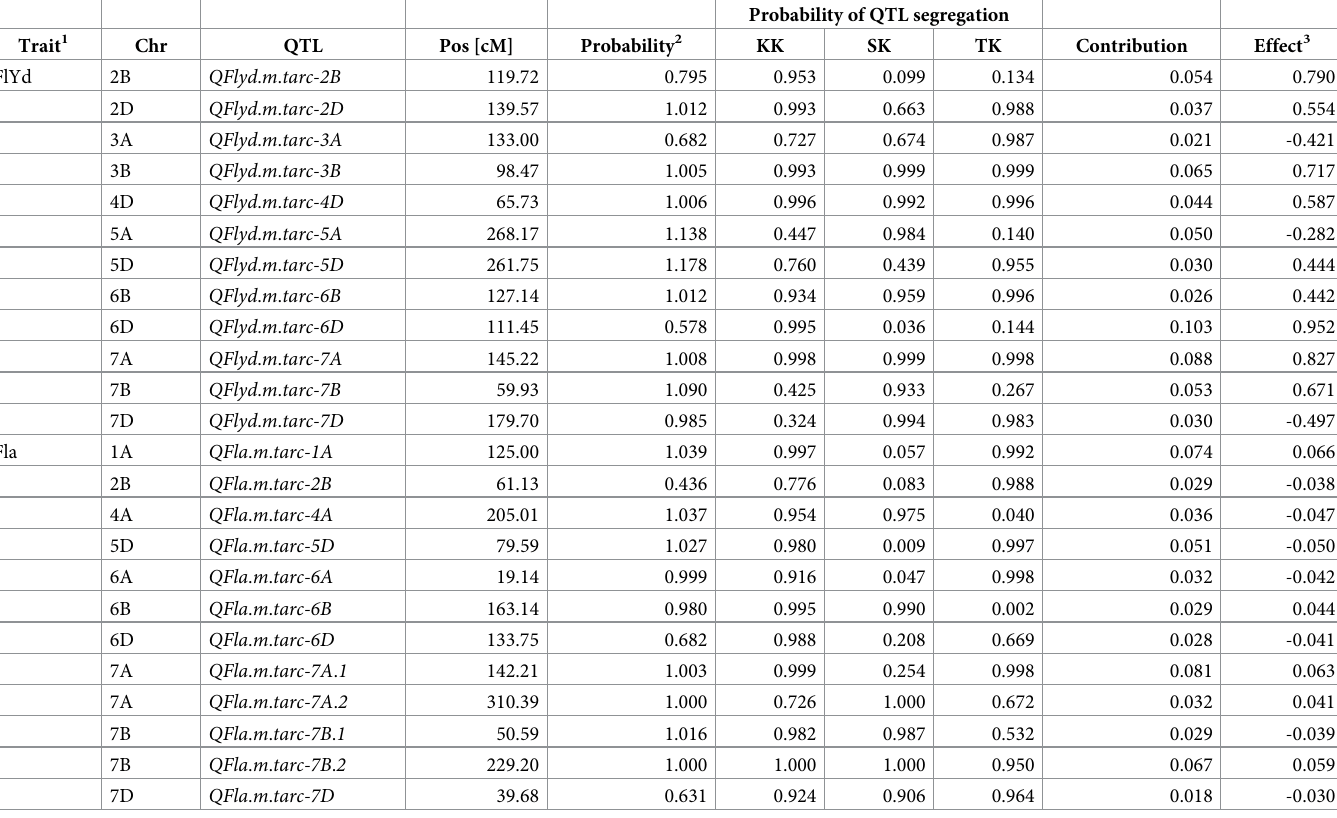
Table 4. Flour yield and flour color a � QTLs detected by multifamily analysis.